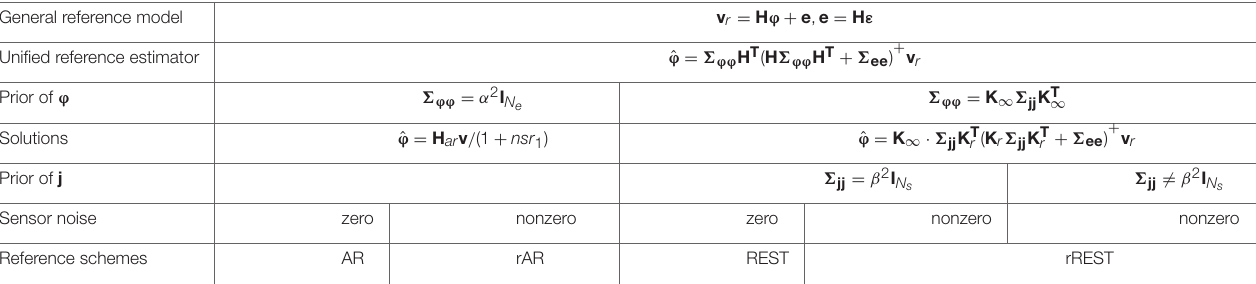
TABLE 1 | EEG reference model, unified estimator and schemes. General reference